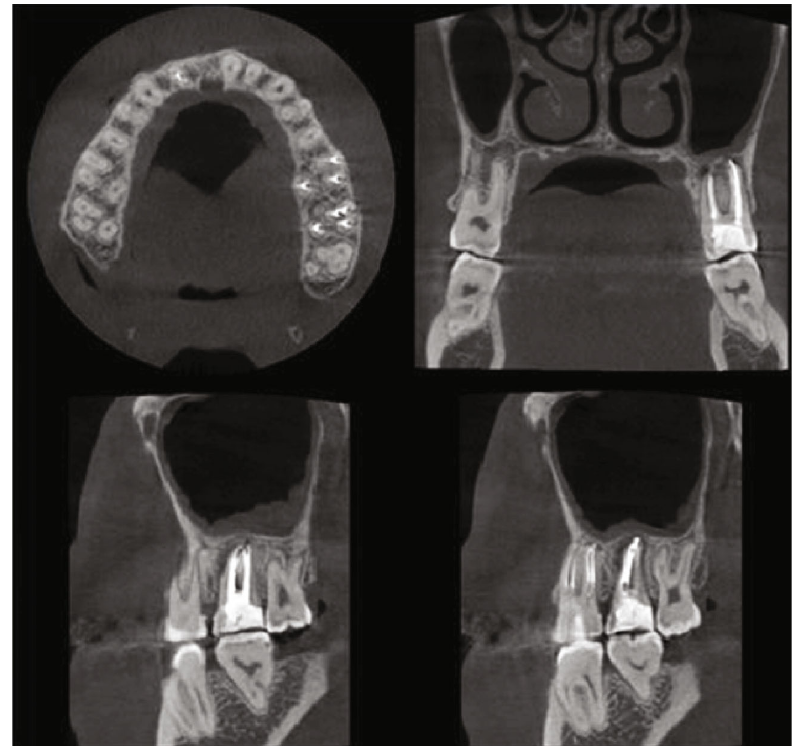
Figure 9: CBCT after obturation. Axial, coronal, and sagittal views.